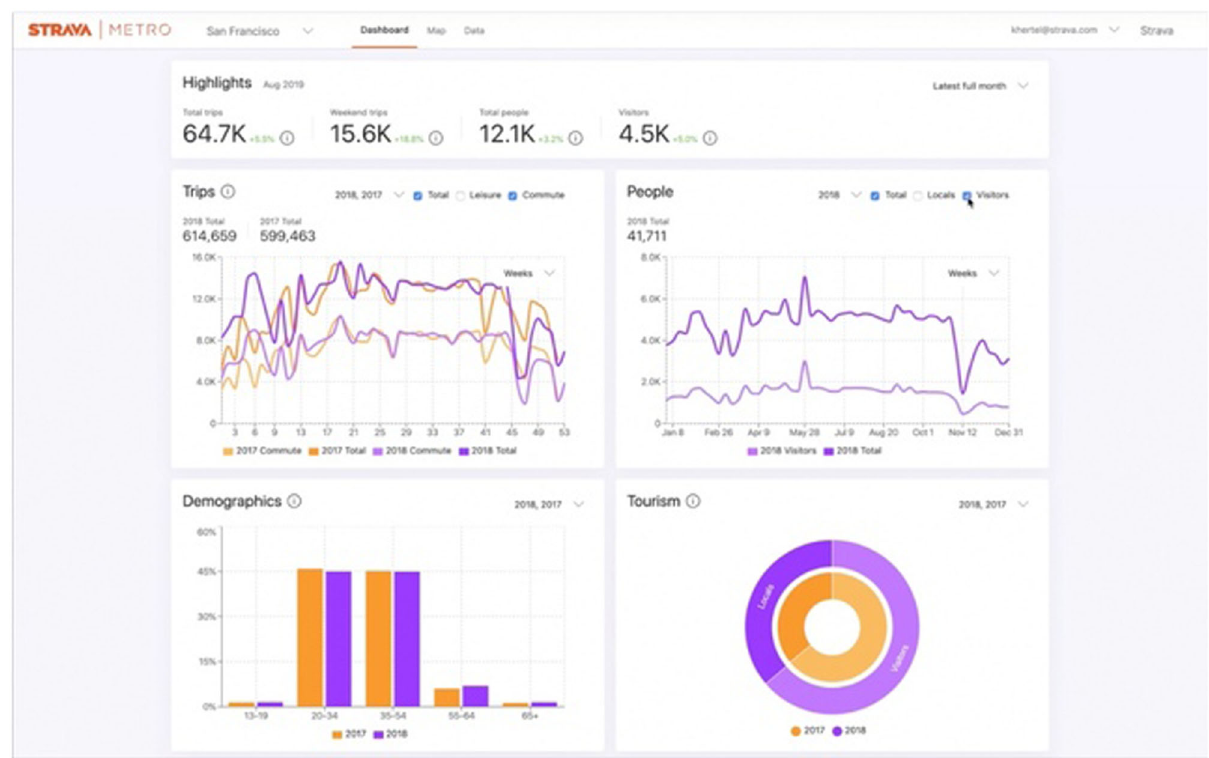
Fig. 6 A screenshot of the Strava Metro dashboard for San Francisco, as shown in a demo video for the product (Strava,